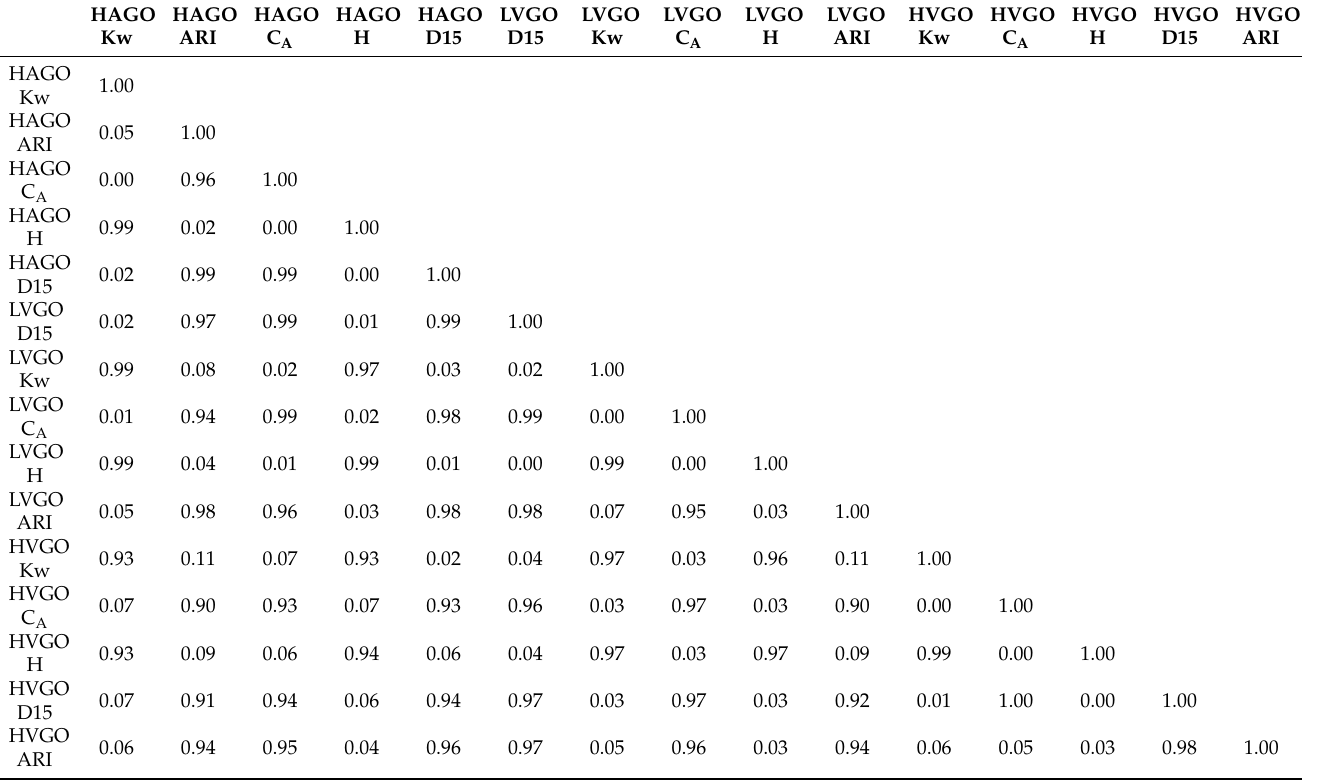
Table 1. µ -value of ICrA for the evaluation of relations between H-Oil ® gas oils parameters contents of aromatic carbon, and hydrogen, and density, and molecular